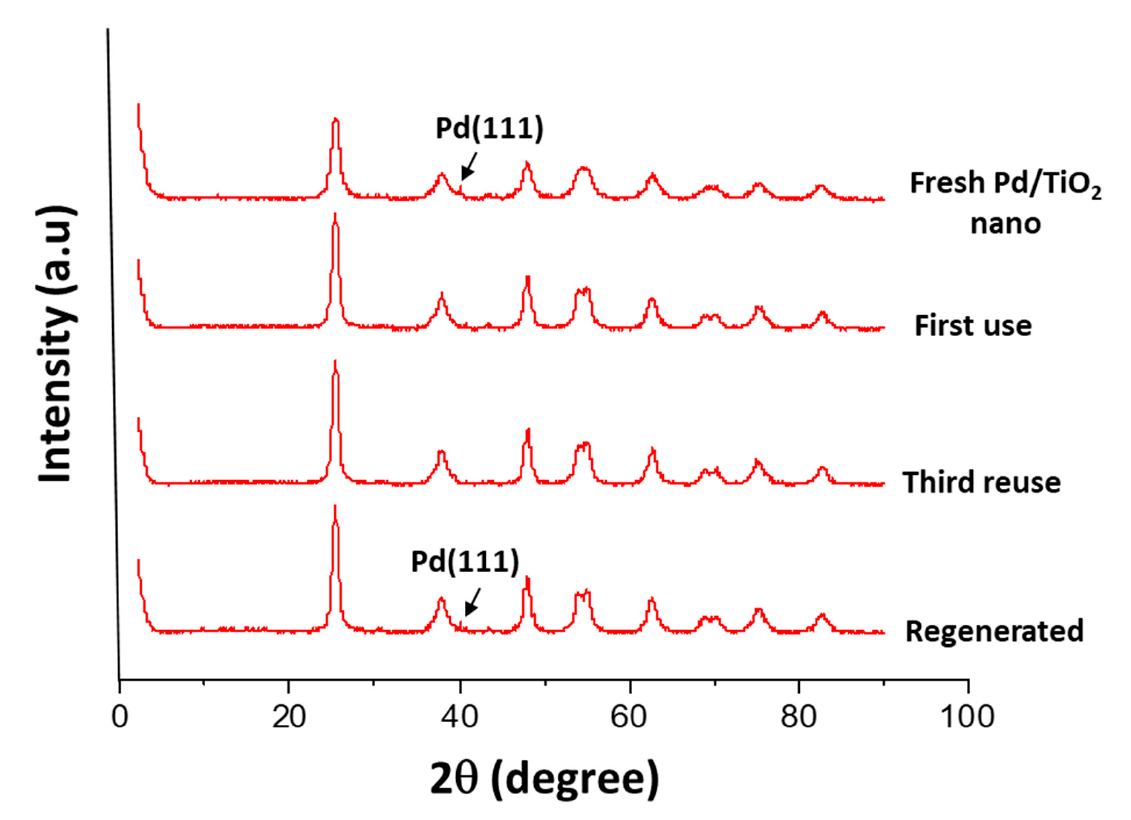
Figure 10. X-ray diffraction patterns of fresh, after uses and after regeneration (with H 2 ) of Pd/TiO 2 nano catalyst.